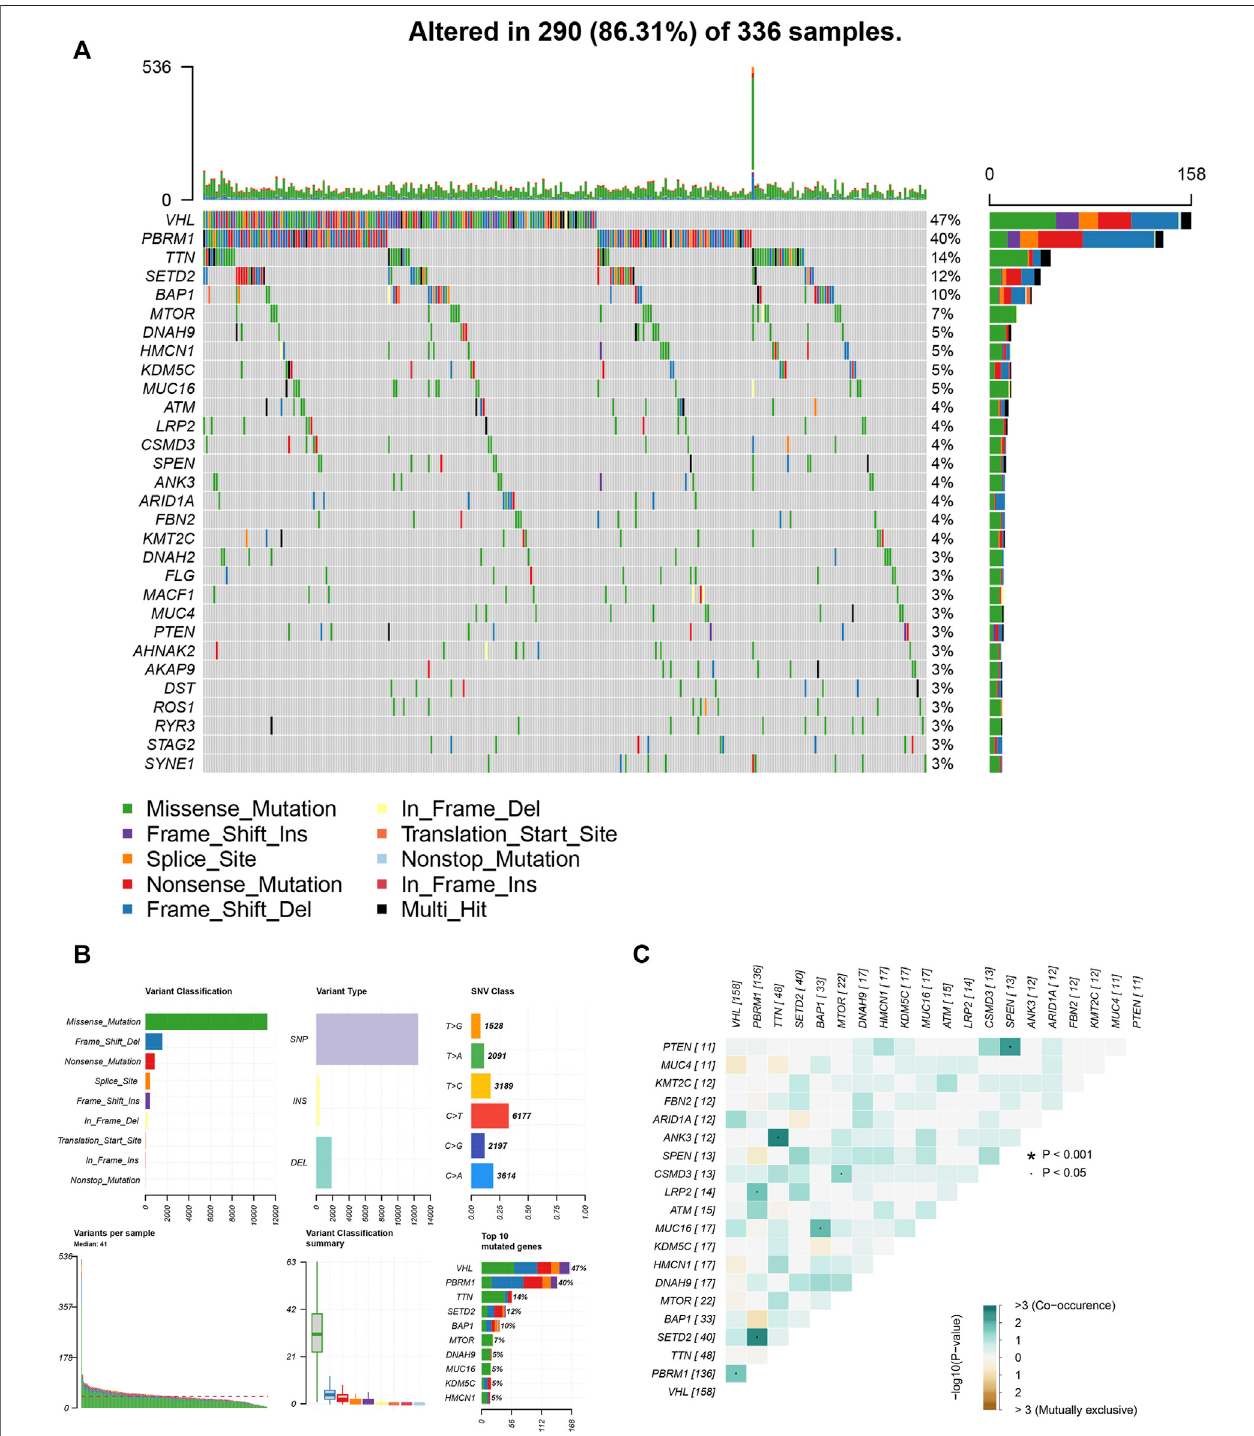
FIGURE 5 | The association between ICI score and somatic variants. (A) The R package “ maftools ” analyzed the somatic gene variants in KIRC. (B) A detailed analysis of the variants. (C) The interaction among mutation genes.